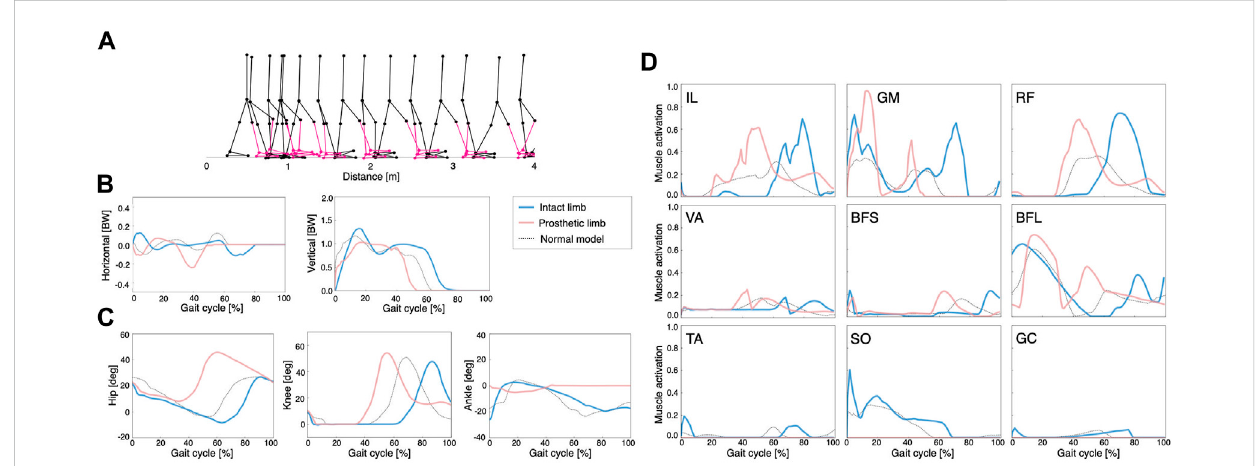
FIGURE 4 Simulation results of the asymmetric control model: (A) stick diagram of the asymmetric control model with the right ankle muscles removed and replacedbyatranstibialprosthesis(red), (B) groundreactionforces, (C) jointangles,and (D) muscleactivations.Dashedlinesrepresentdataofthenormal model. Blue and red lines indicate intact and prosthetic limbs, respectively.